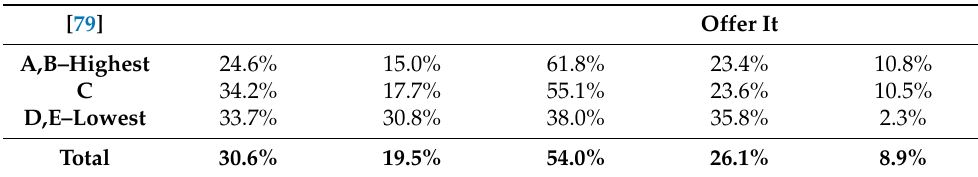
Table 9. What are the reasons why you do not eat game in a restaurant? (Base: 200 respondents either eat game food only at home or do not, multiple answers